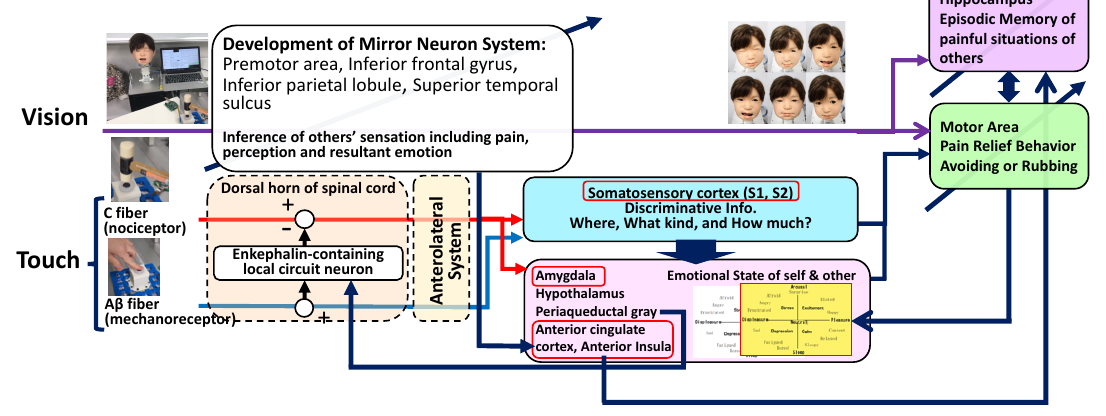
Figure 9. The sharing of pain